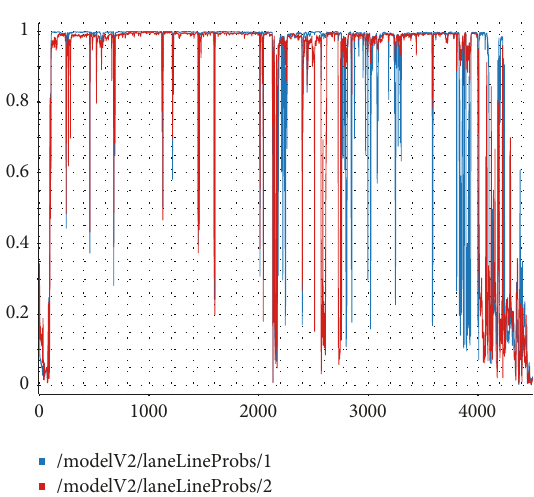
Figure 49: T2D3 left (1) and right (2) lane recognition.